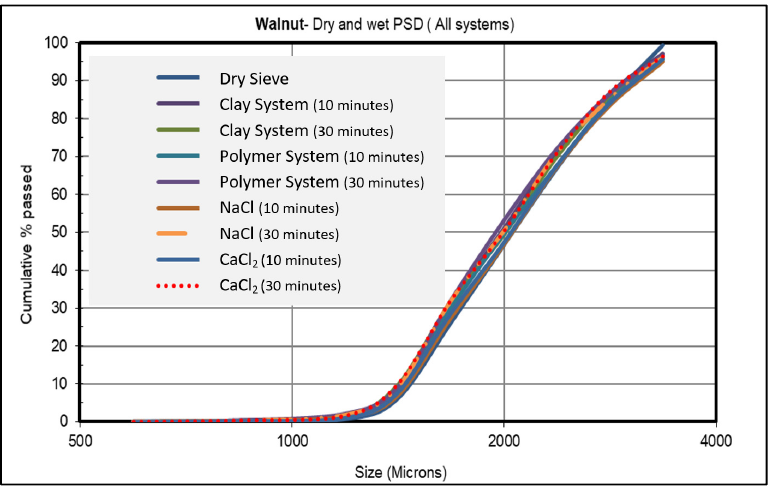
Figure 2. Dry and wet PSD of walnut in the four carrier fluid systems with 10 and 30 min shearing intervals.